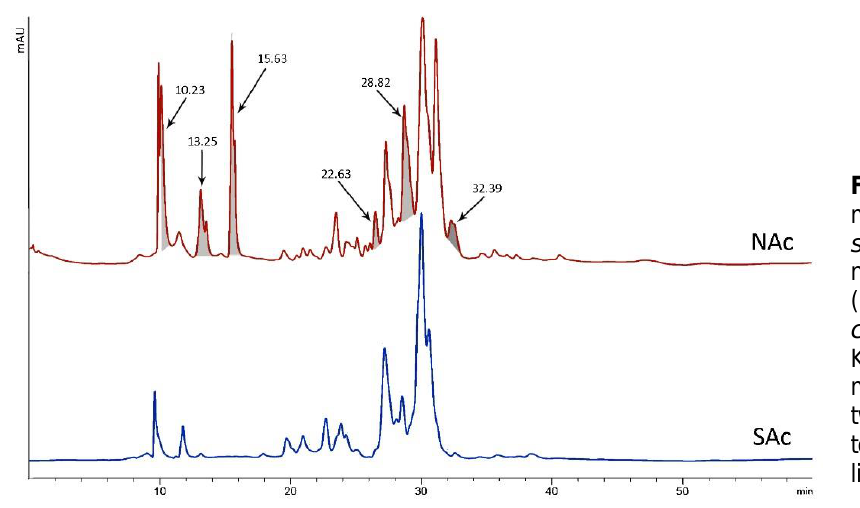
Figure 2: HPLC chro- matograms for A. cras- sicauda venom living in northern (NAc) and A. crassi- main differences be- tograms